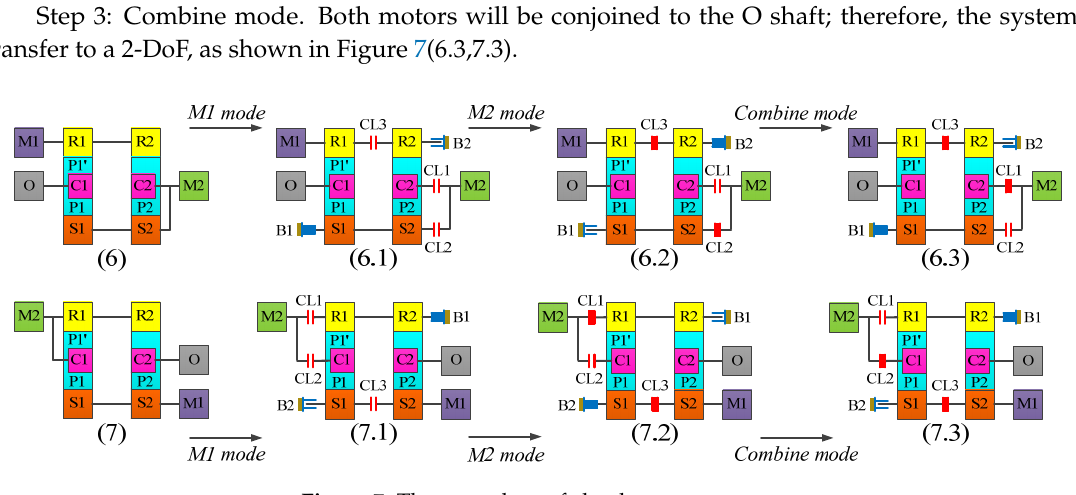
Figure 7. The procedure of clutch arrangement.